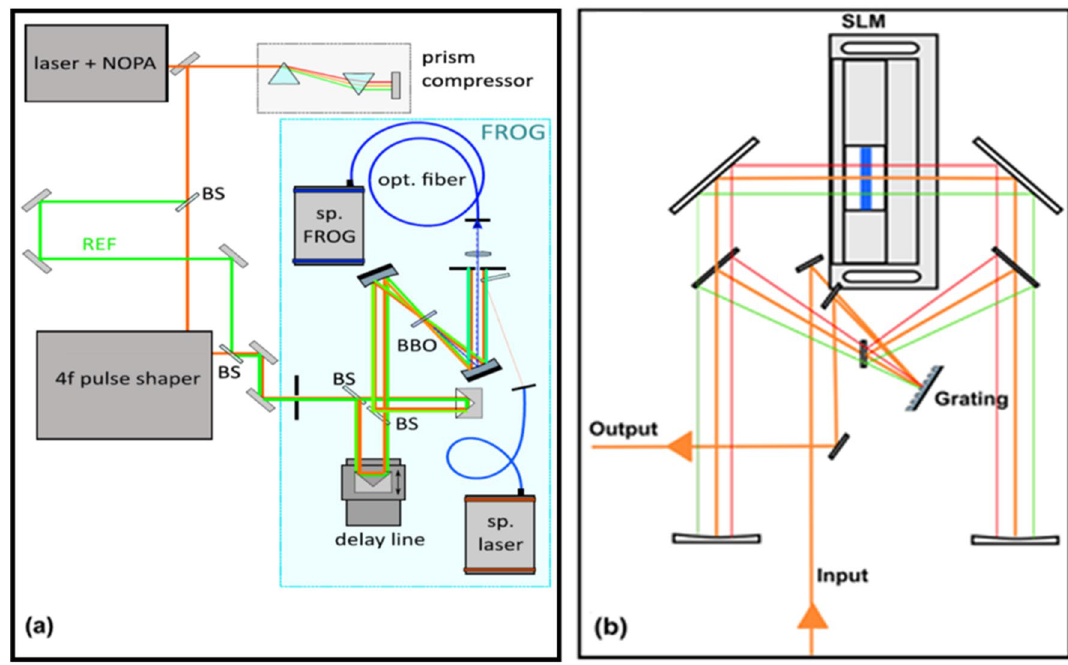
Figure 1. ( a ) The used experimental setup for the FROG (red beam only) and XFROG (both red and green beams are used). ( b ) The used pulse shaper in 4f geometry. See text for details of both